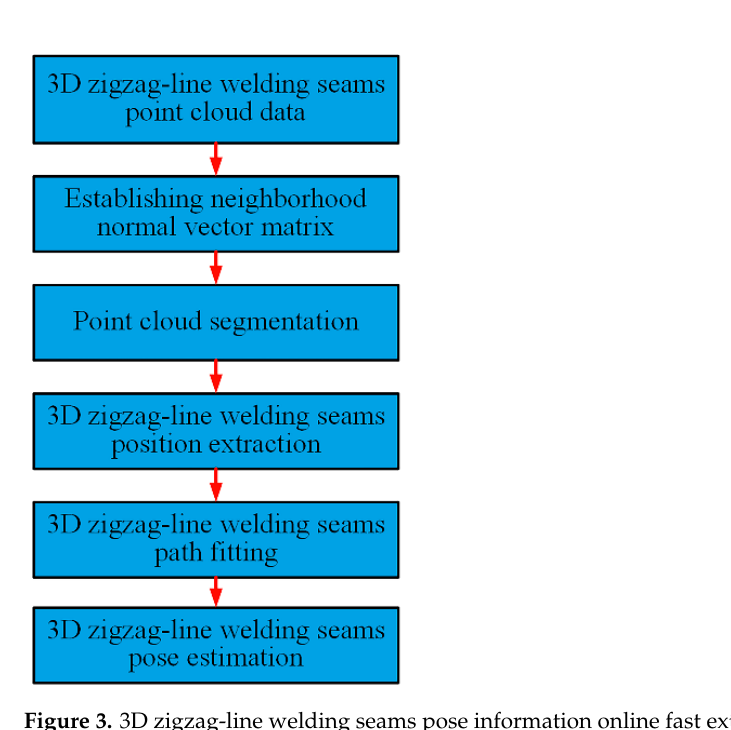
Figure 3. 3D zigzag-line welding seams pose information online fast extraction process.